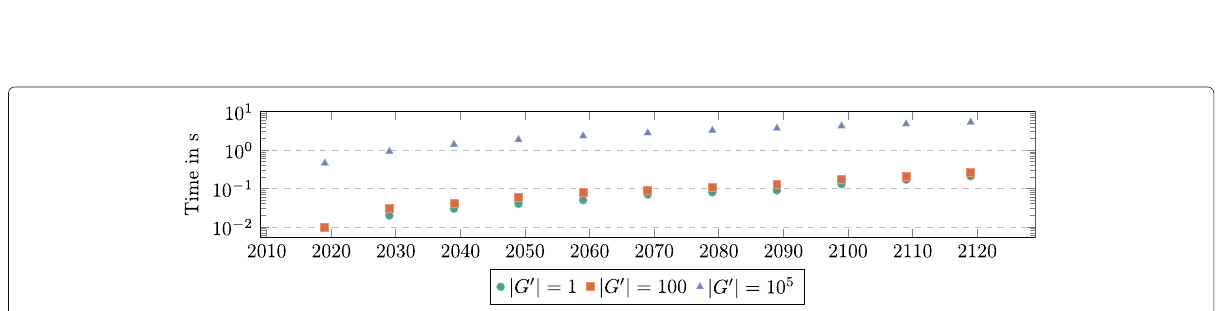
Fig. 6 Computation time for verifying partial integrity proof for partial genome data G